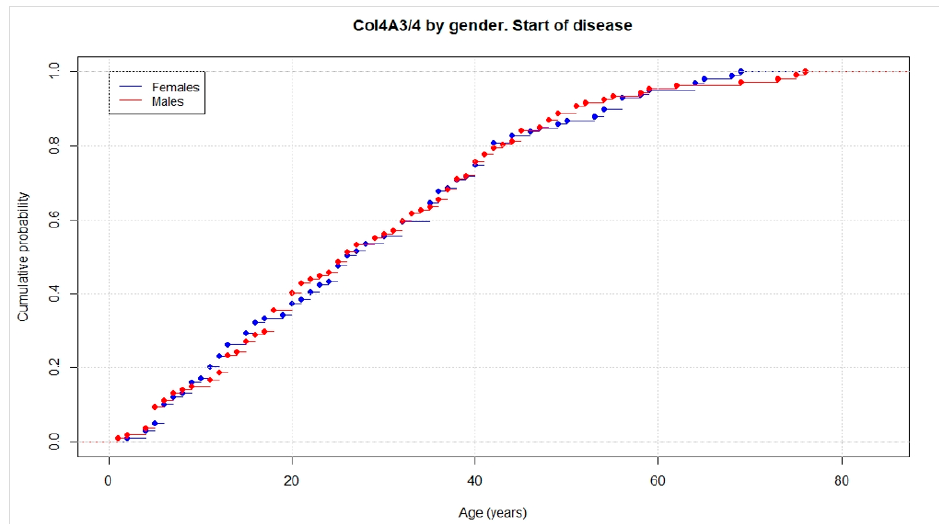
Figure 1. The cumulative probability of urine analytical abnormalities (microhematuria, hematuria, proteinuria) against age. This graph represents the age of onset of renal disease in the 317 patients with heterozygous deleterious mutations in COL4A3 and COL4A4 in this cohort. No differences were observed between the male (in red ) and female (in blue ) patients.